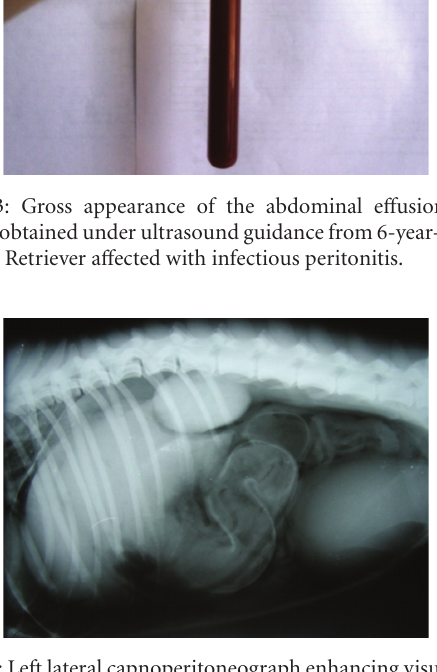
Figure 6: Grasping of jejunal loop under laparoscopic-guidance for performing laparoscopic guided and laparotomy assisted introper- ative mesenteric portography in 1-year-old male mixed breed dog with progressive